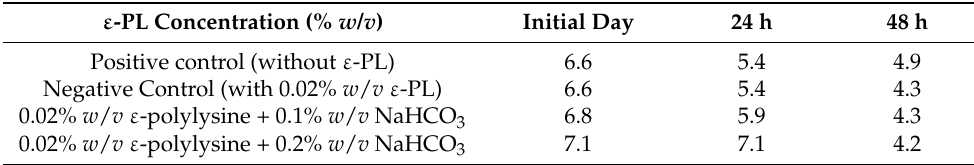
Table 3. pH monitoring of control milk sample and other milk samples added with bicarbonate and ε